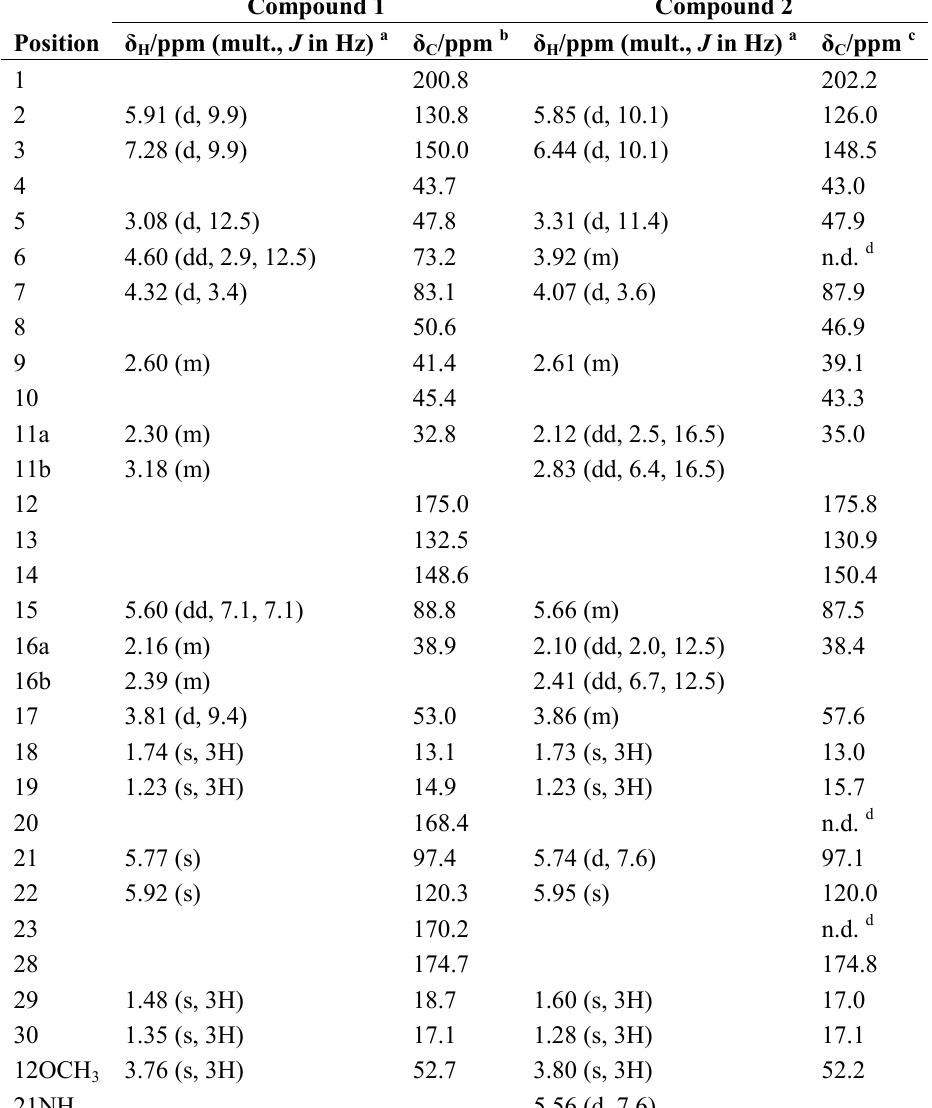
Table 1. NMR data for compounds 1 and 2 in CDCl